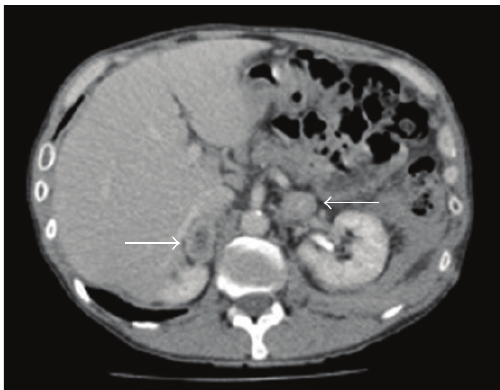
Figure 3: Axial CT image at the level of the adrenal glands demon- strating bilateral adrenal masses